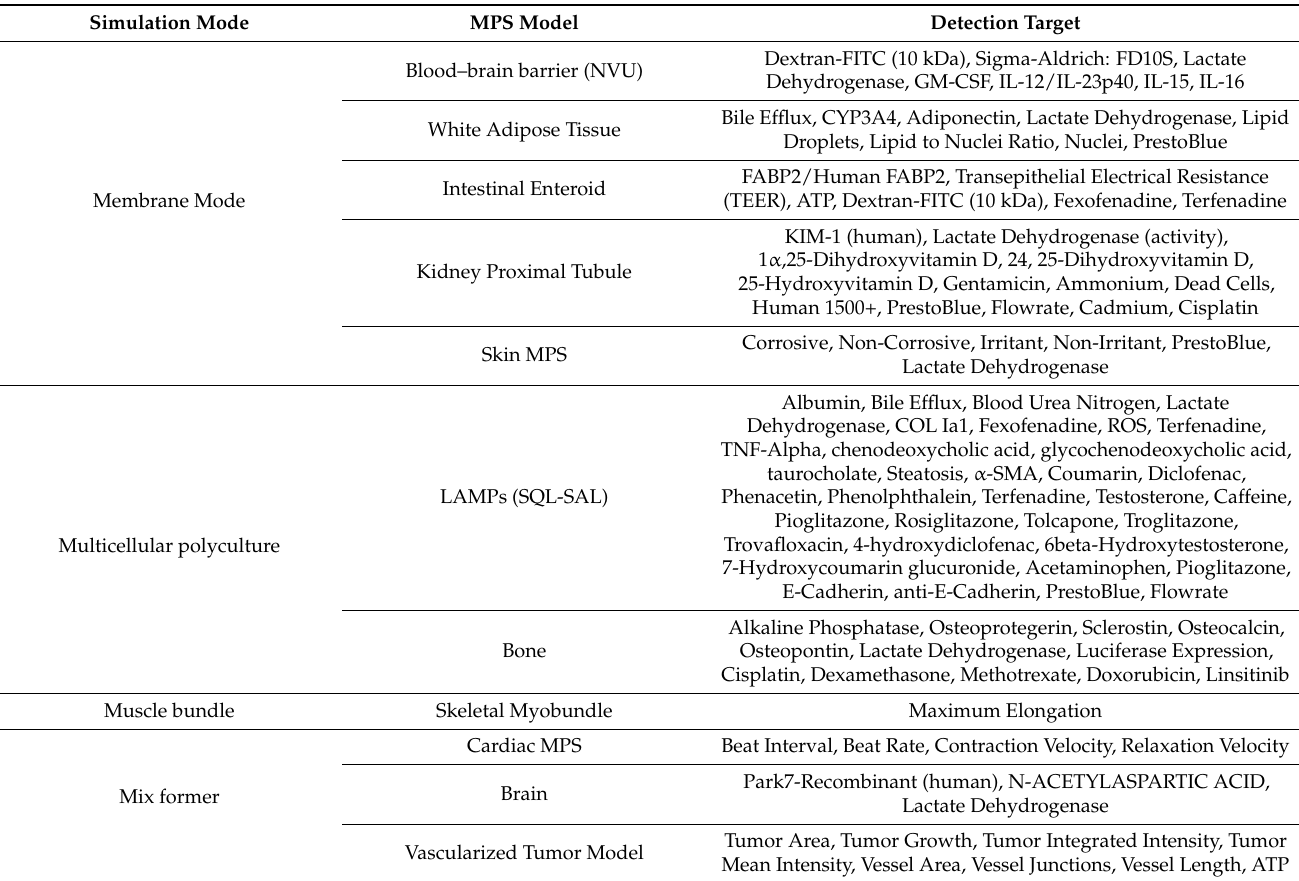
Table 2. Detection targets of MPS models in the